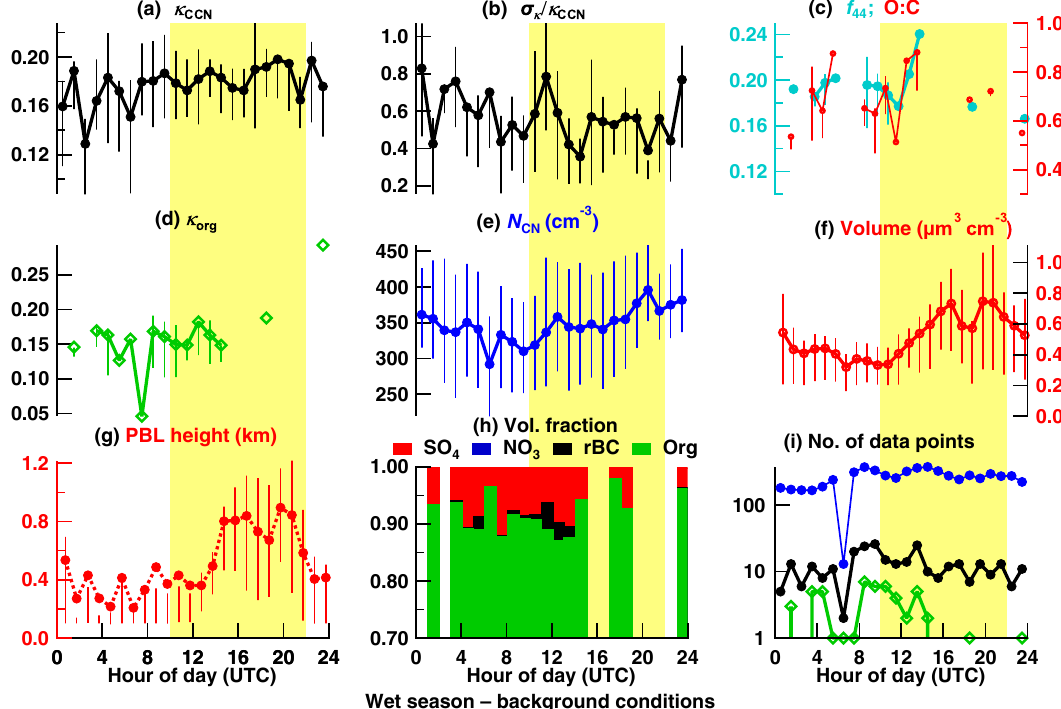
Figure 3. Diel variations of aerosol properties and meteorological parameters under background conditions during the wet season, including /κ CCN , (c) fraction of the organic mass at m/z = 44 ( f 44 ) and the elemental ratio O:C, (d) κ org derived using size- (a) κ CCN , (b) σ κ CCN resolved particle composition, (e) the total number of condensation nuclei ( N CN ), (f) the total aerosol volume derived from size distribution measured by the SMPS in MAOS, (g) planetary boundary layer height as estimated using the ceilometer data, (h) the volume fractions of aerosol species, and (i) the number of samples in each hour bin corresponding to the data by the same colors and symbols in their respective /κ CCN , κ org , and the volume fraction of aerosol species were averaged over three particle diameters of 112, panel. The values of κ CCN , σ κ CCN 142, and 171nm. The values of f 44 and O:C were derived from the AMS bulk measurements. Data include the last 2 weeks of March 2014 when valid data from both size-resolved CCN system and AMS were available. Data points are hourly averaged mean values; error bars represent the 25th and 75th percentiles of the data. Yellow shading represents the local daytime